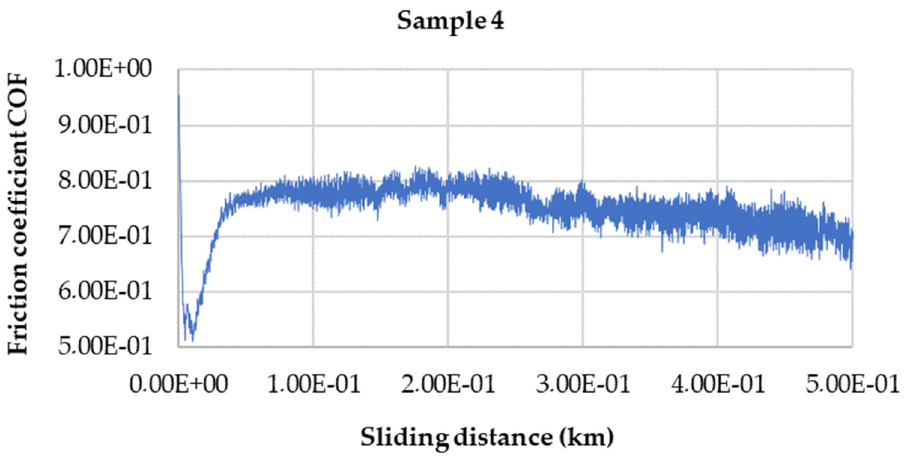
Figure 9. Course of COF for Ni-Co coatings (Sample 4) deposited at 6 A dm − 2 . The effect of Co content in Ni-Co alloy on COF at room temperature in the tribo test and at 400 °C is shown in Figure 10.